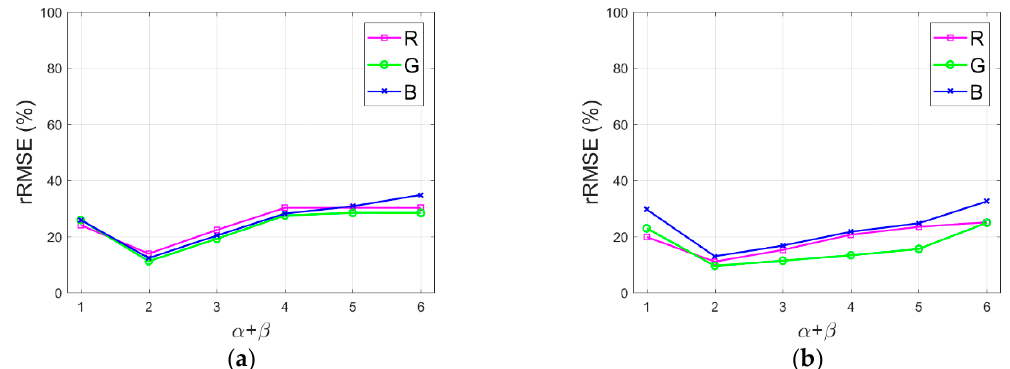
Figure 12. rRMSE of shadow compensation results with various α β+ values for test Figure12. rRMSEofshadowcompensationresultswithvarious α + β valuesfortestimages. ( a )Tripoli-1. ( b ) images. ( a ) Tripoli-1. ( b ) Tripoli-2.